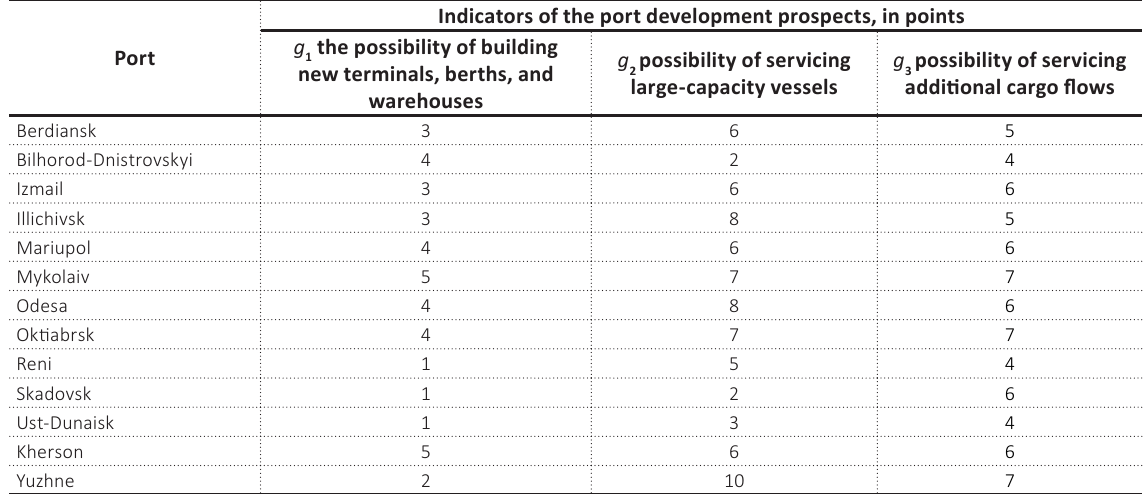
Source: Developed by the authors.